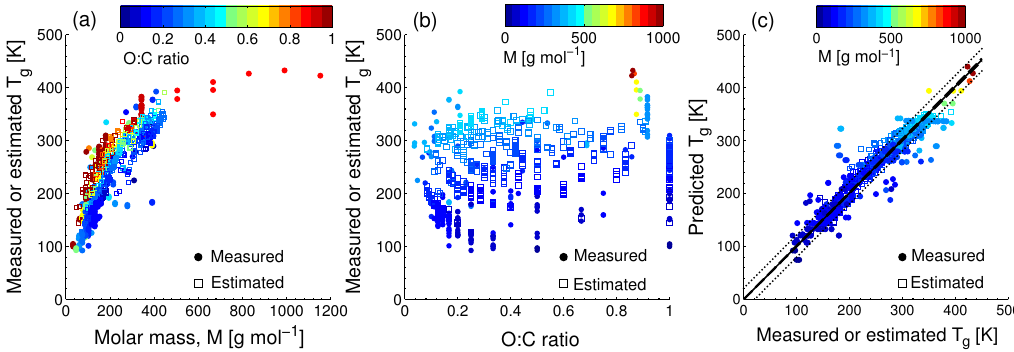
Figure 1. Characteristic relationships between molecular properties and the glass transition temperature ( T g ) of organic compounds. (a) T g of organic compounds as measured (circles) and estimated with the Boyer–Kauzmann rule (squares) plotted against molar mass. The markers are color coded by atomic O:C ratio. (b) Measured (circles) and estimated (squares) T g of organic compounds plotted against the O:C ratio. The markers are color coded by molar mass. (c) Predicted T g for CHO compounds using a parameterization (Eq. 2) developed in this study compared to measured (circles) and estimated T g by the Boyer–Kauzmann rule (squares). The solid line shows the 1 : 1 line and the dashed and dotted lines show 68% confidence and prediction bands, respectively. Table 1. Composition classes and the n 0 and b values (K) for glass transition temperature parameterizations obtained by C